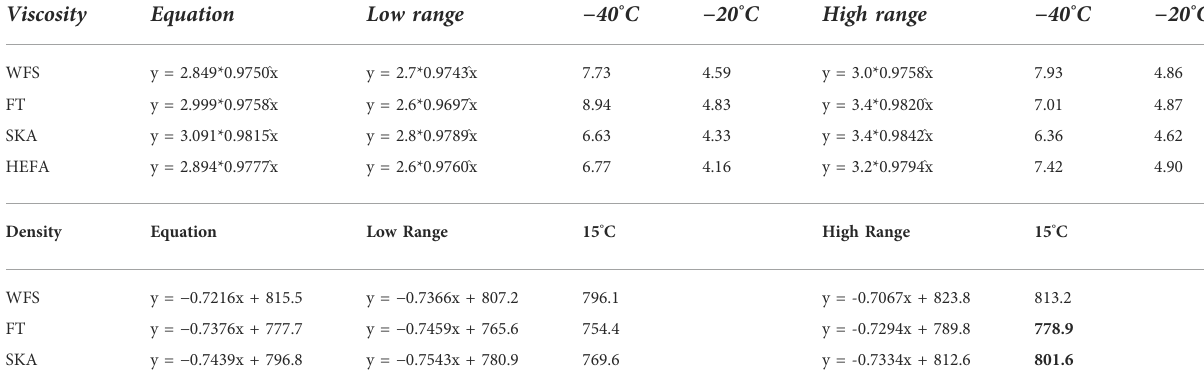
TABLE 8 Viscosity ranges for SAF at − 40 ° C and − 20 °